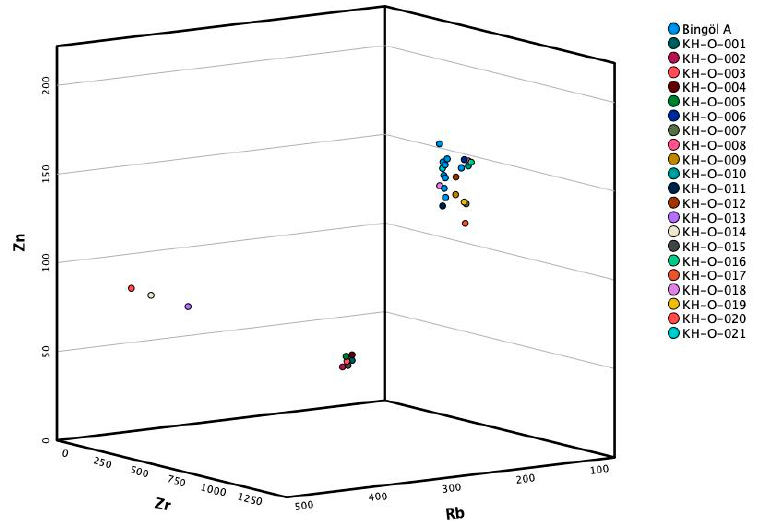
Figure 12. Ternary plot of Zr, Rb and Zn showing obsidian artefacts and Bingöl A geological sam- ples.